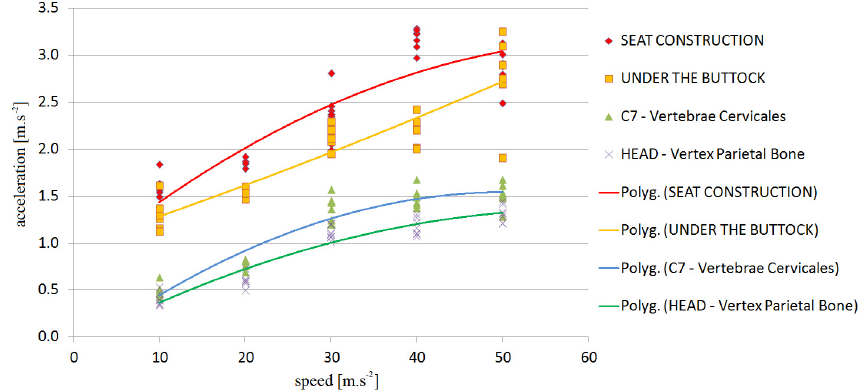
Figure 7. DRIVER-dependence of vehicle speed on acceleration—V1 to V35.